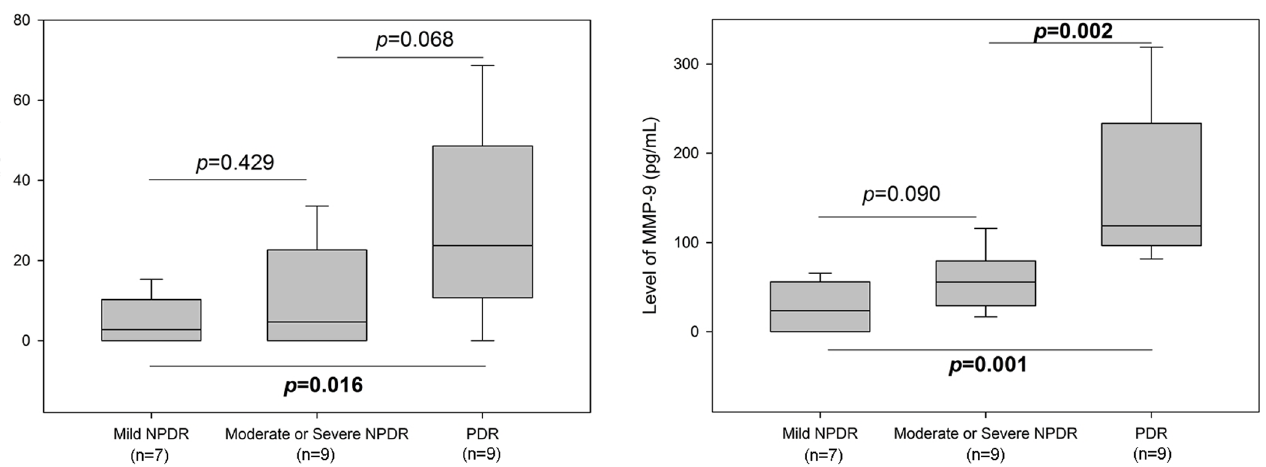
PLOS ONE | DOI:10.1371/journal.pone.0159720 July 28,